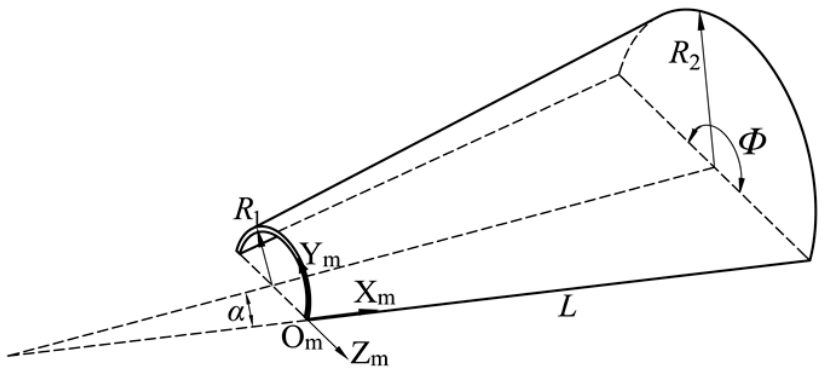
Figure 6. Schematic diagram of the semi-conical shell workpiece and coordinate system O m -X m Y m Z m . The boundary conditions of the semi-conical workpiece are set based on the practical condition shown in Figure 2a. The workpiece is fixed on three separate fixtures with HY-194 epoxy adhesive, and all three fixtures are mounted on the worktable of the machine-center with T-shaped bolts, which will a ff ect the sti ff ness distribution of the workpiece. In the calculation process, the spring sti ff ness of − 1, − 1 the clamped boundary is set as 1 × 10 8 N m and the free boundary is set as 0 N m . It should be pointed out that two straight boundaries located at y m = 0 and y m = Φ are clamped partially instead of totally, and two semicircle boundaries located at x m = 0 and x m = L are free. The potential energy of the boundary constraints can then be calculated based on the boundary conditions and the theory of